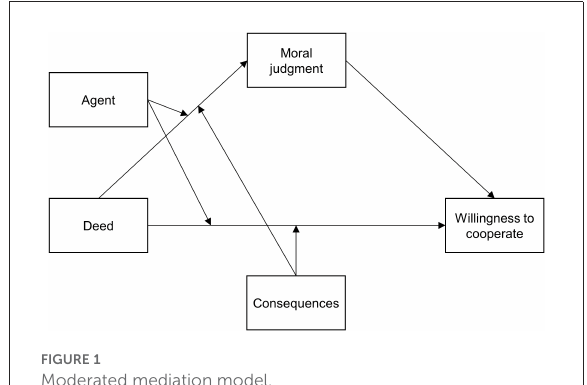
FIGURE1 Moderated mediation